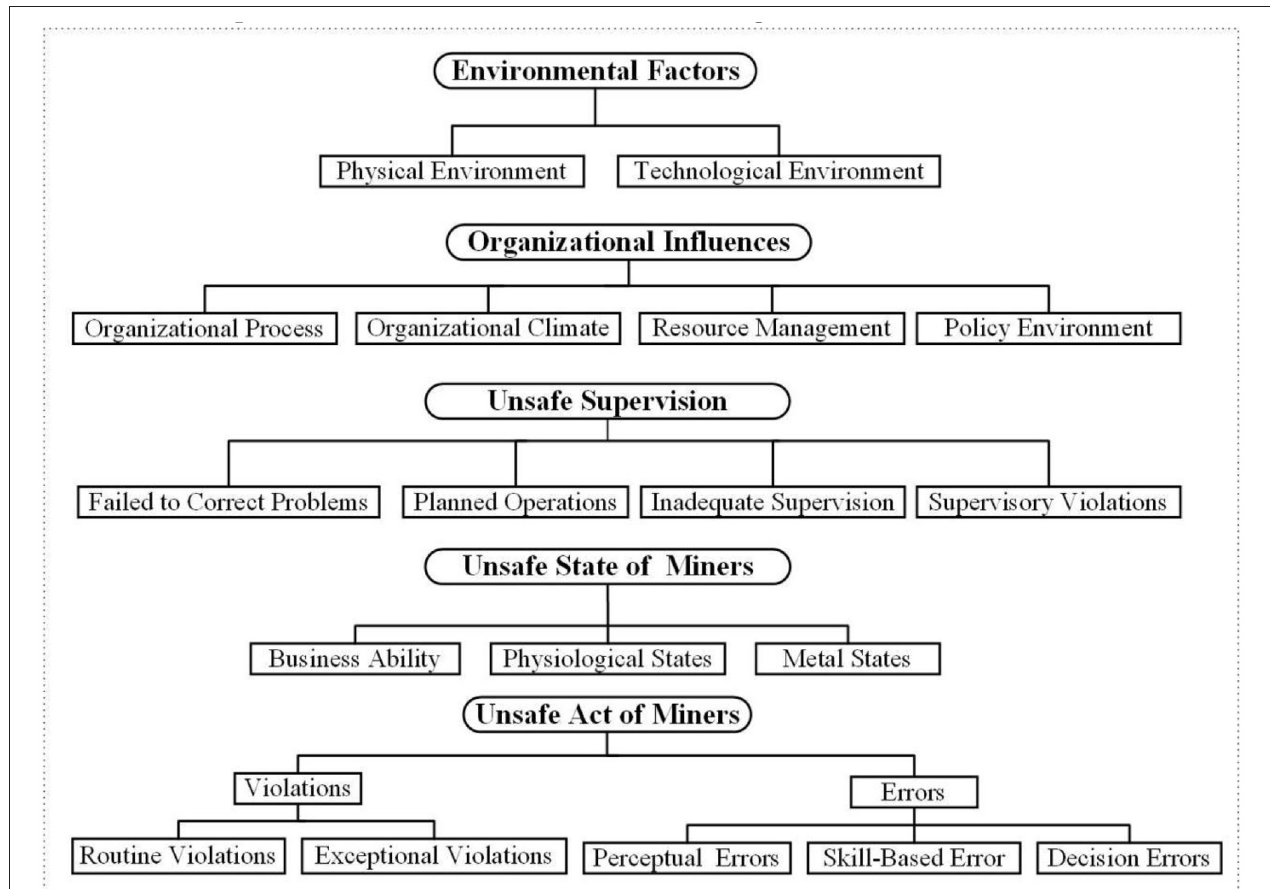
FIGURE 2 | The improved framework of